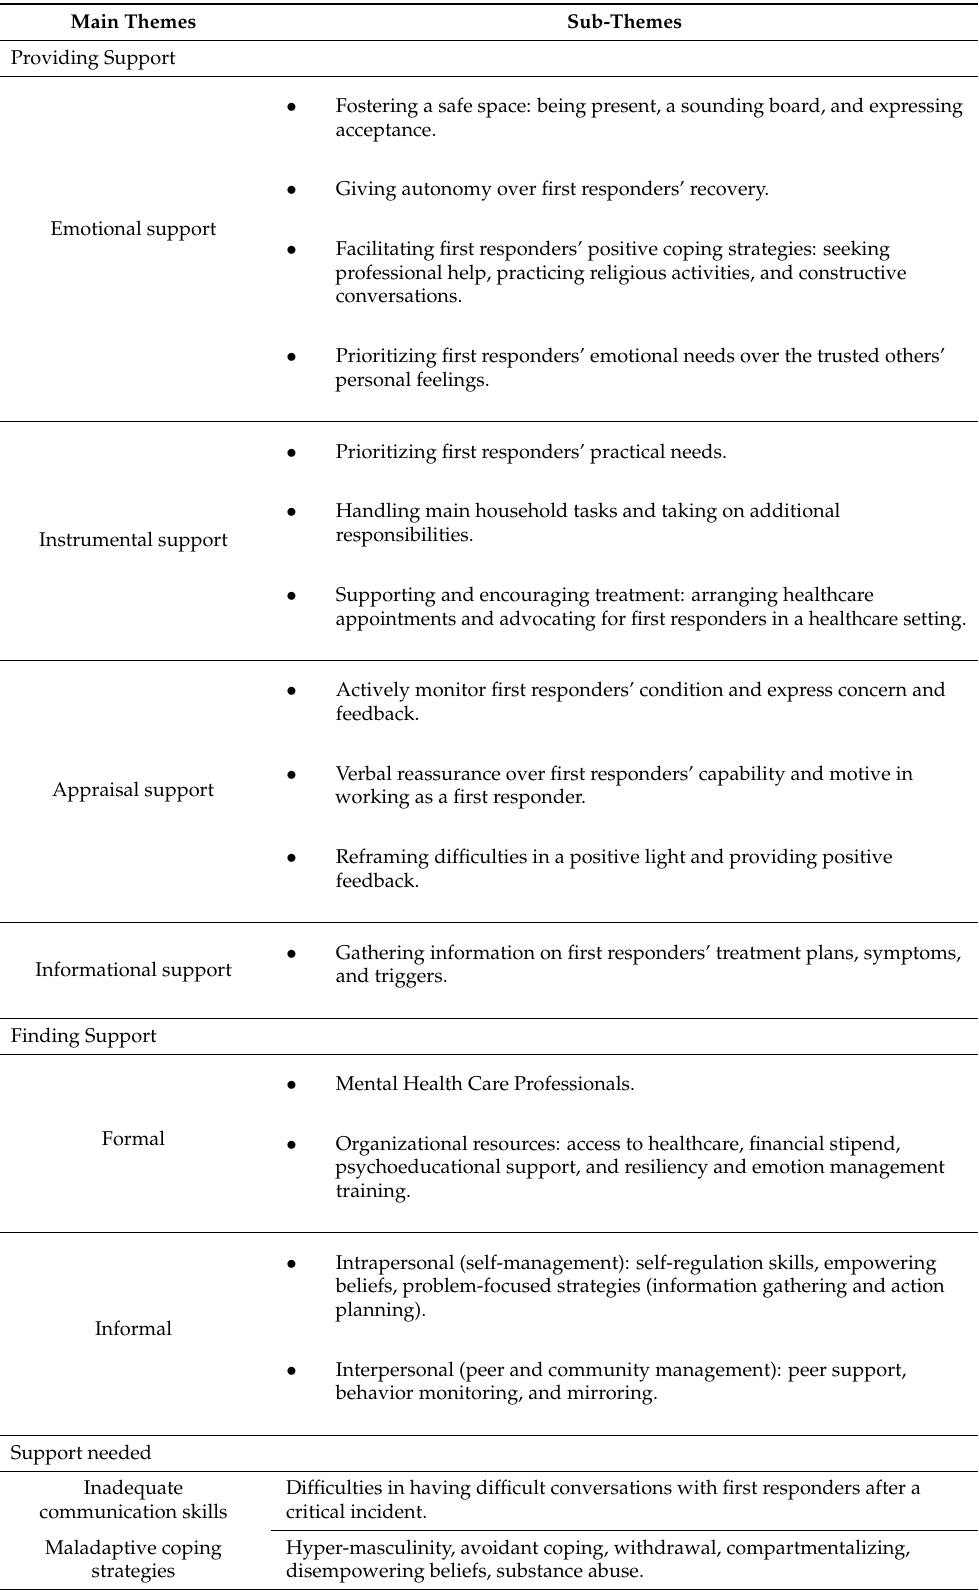
Table 3. Summary of